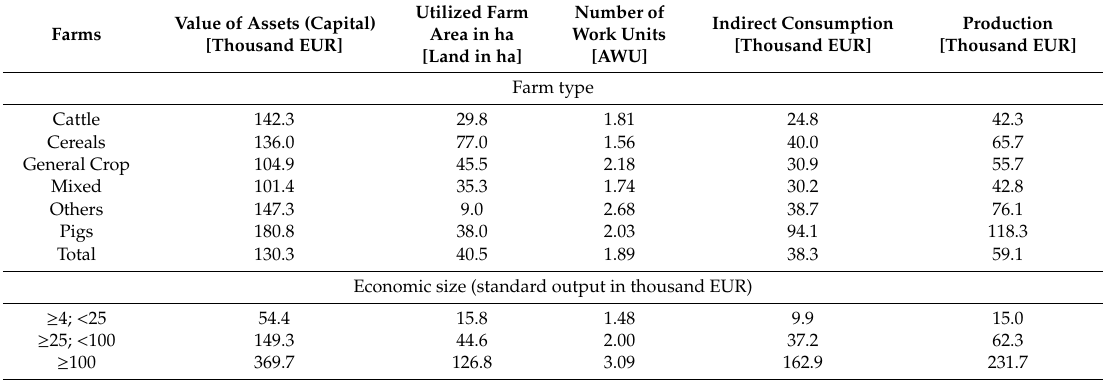
Table 1. Average values of inputs and